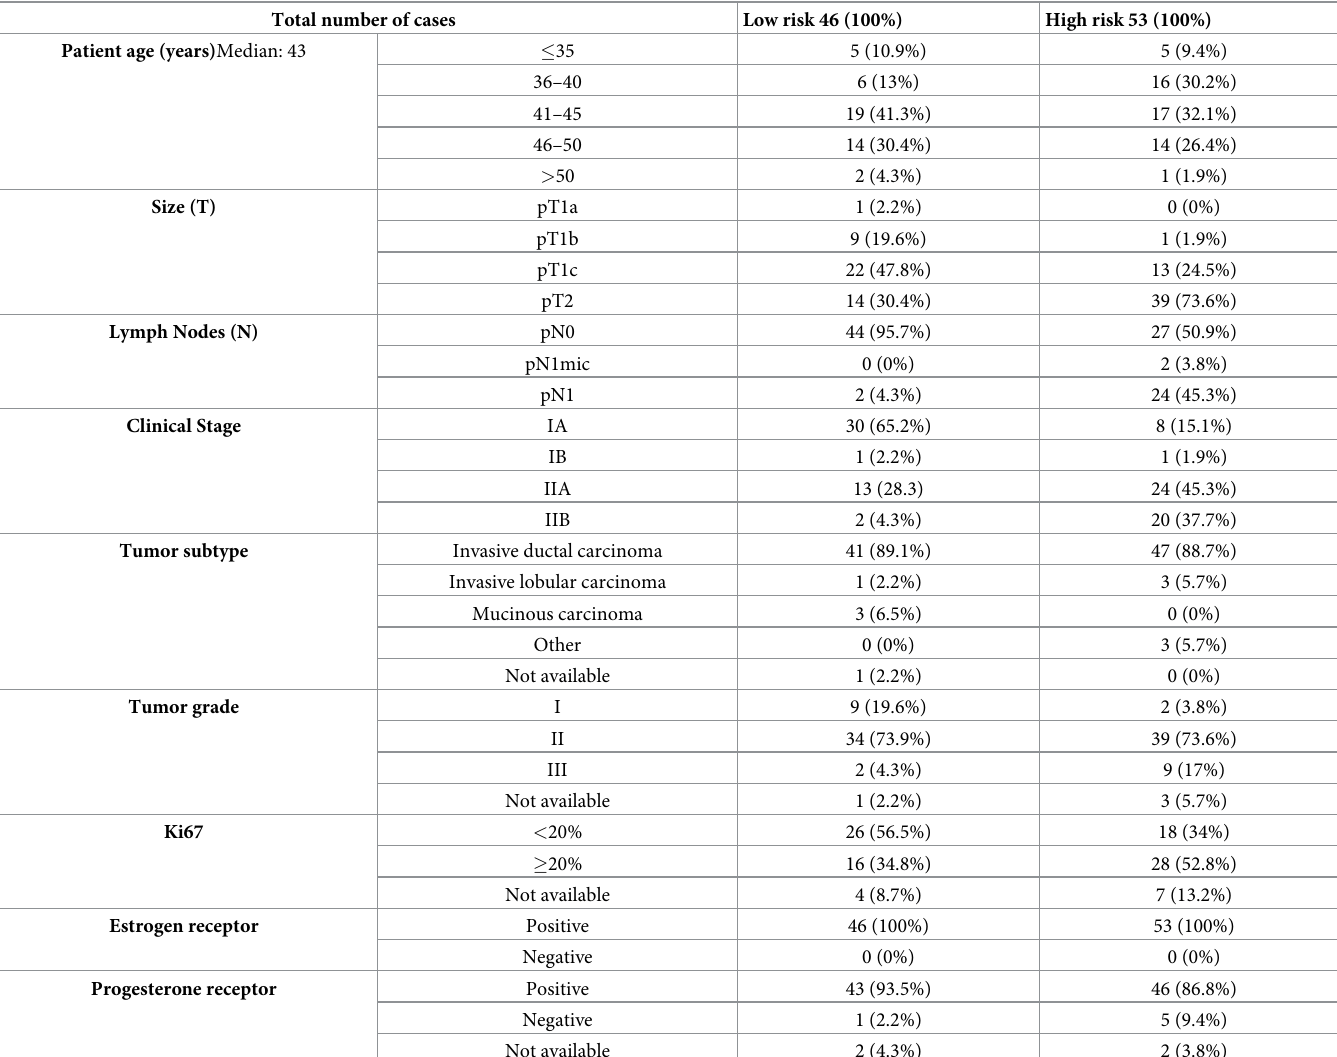
Table 2. Patients’ clinical and pathological characteristics by EPclin risk